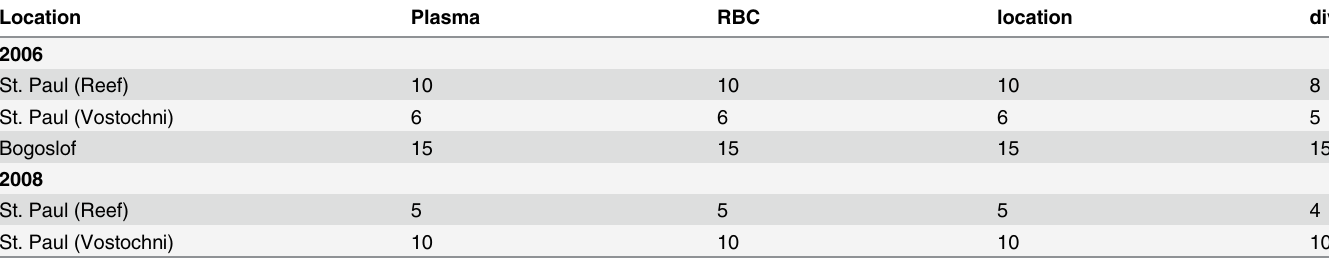
Table 1. Number of northern fur seal stable isotope samples, location data and dive data collected in 2006 and